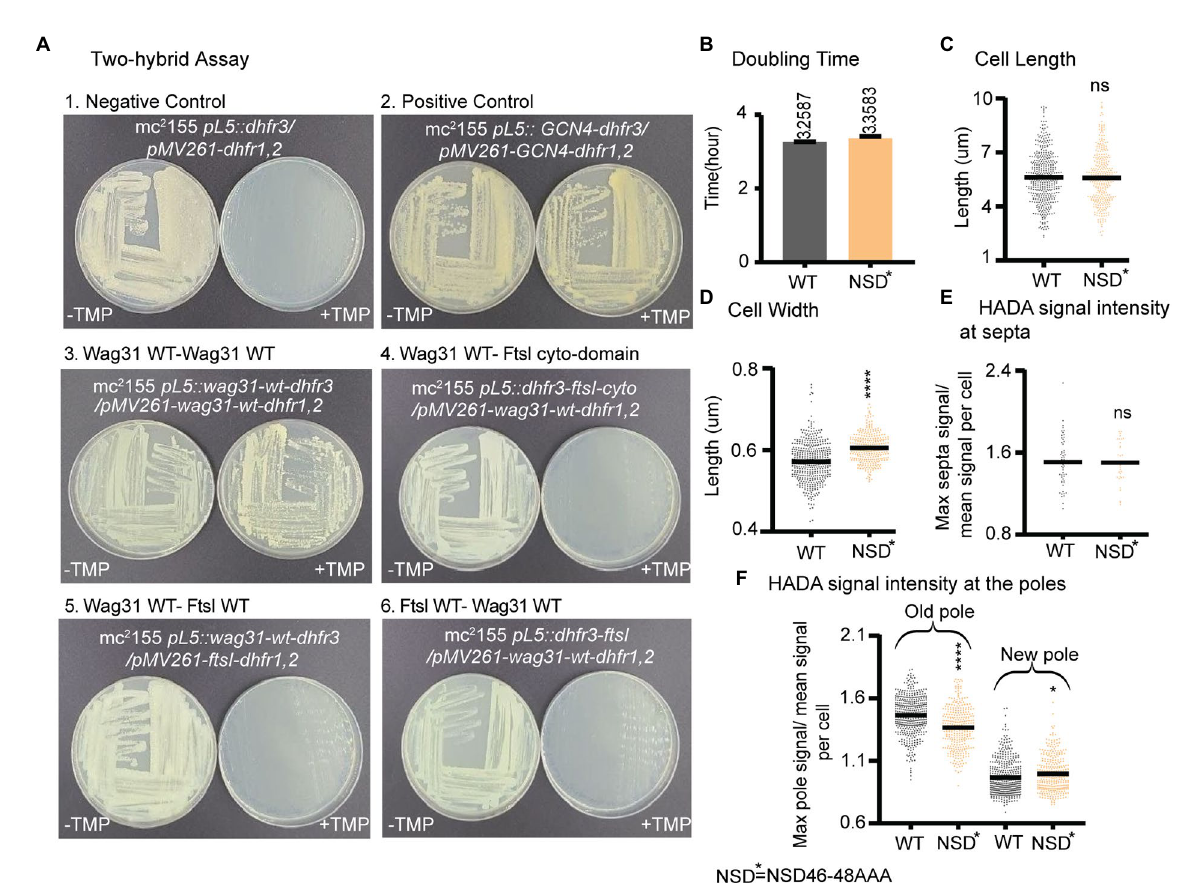
FIGURE 6 Wag31 does not regulate FtsI in logarithmic phase through residues NSD46-48. (A) Representative plates from the Mycobacterial Protein Fragment Complementation two-hybrid assay. Indicated strains were struck out on plates with and without trimethoprim (+TMP/ -TMP). (B) Doubling times of Msmeg cells expressing WT or wag31 NSD46-8AAA mutant. (C) Cell lengths and (D) Cell width of the wag31 NSD46-8AAA strain. Black bars are at the mean. (E) Relative septal and polar HADA (F) intensity of Wag31 WT and Wag31 NSD46-8AAA. ns, p > 0.05, * p = <0.05, *** p = <0.0005, **** p = <0.0001. p -values were calculated by unpaired t